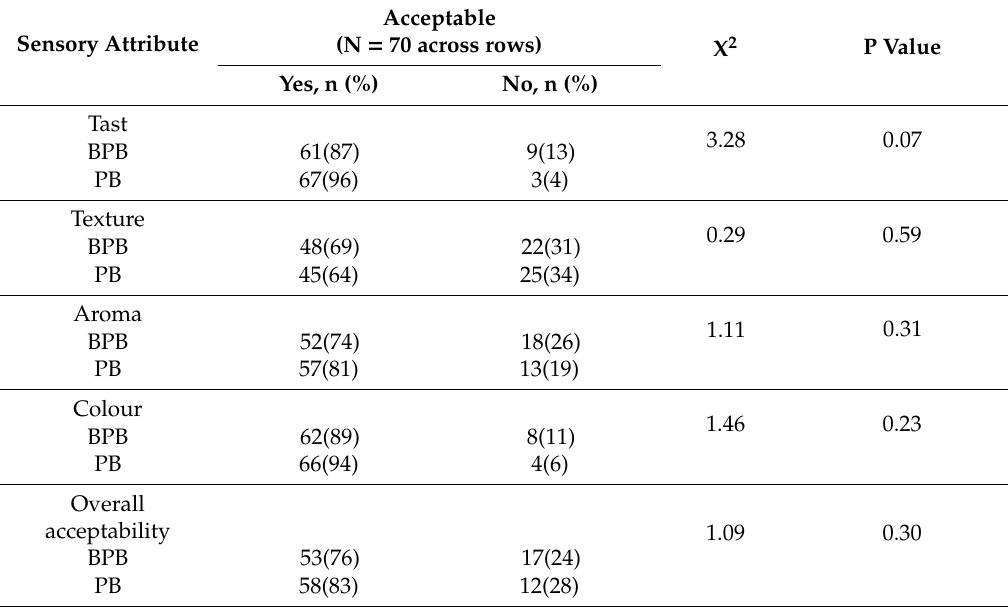
Table 5. Association of sensory acceptability between BPB and